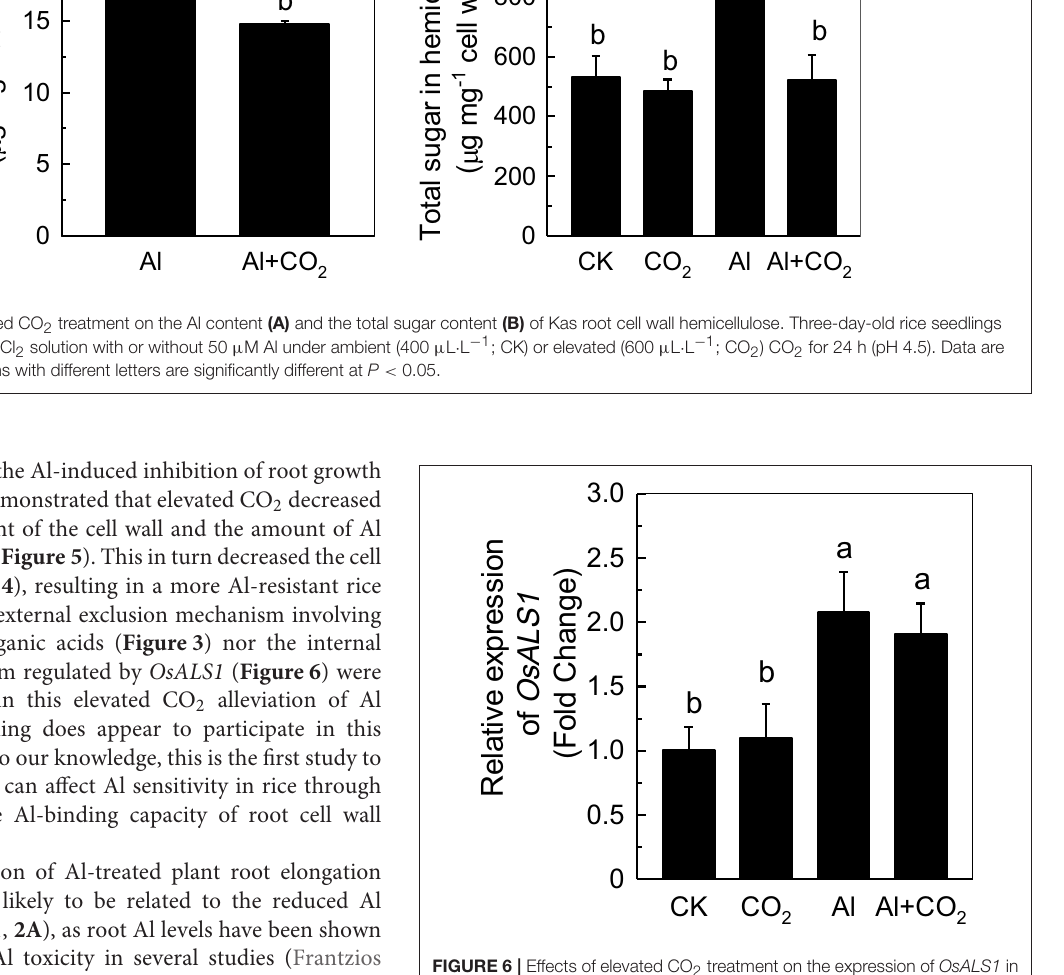
FIGURE 6 | Effects of elevated CO 2 treatment on the expression of OsALS1 in Kas. Three-day-old rice seedlings were treated with 0.5 mM CaCl 2 solution with or without 50 µ M Al under ambient (400 µ L · L − 1 ; CK) or elevated (600 µ L · L − 1 ; CO 2 ) CO 2 for 24 h (pH 4.5). The root apex was excised for RNA extraction. Expression levels of plants grown in ambient CO 2 were assigned as expression level of 1. Data are means ± SD ( n = 4). Columns with different letters are significantly different at P <